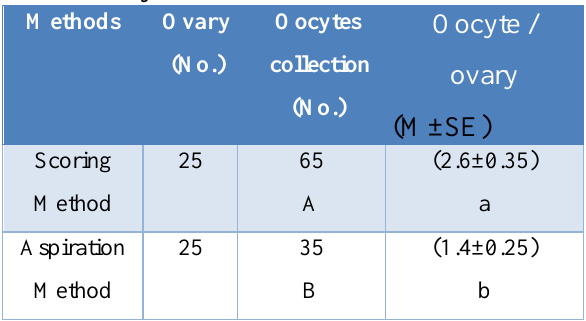
Table,1: The recovery method on quantity of buffalo oocytes.